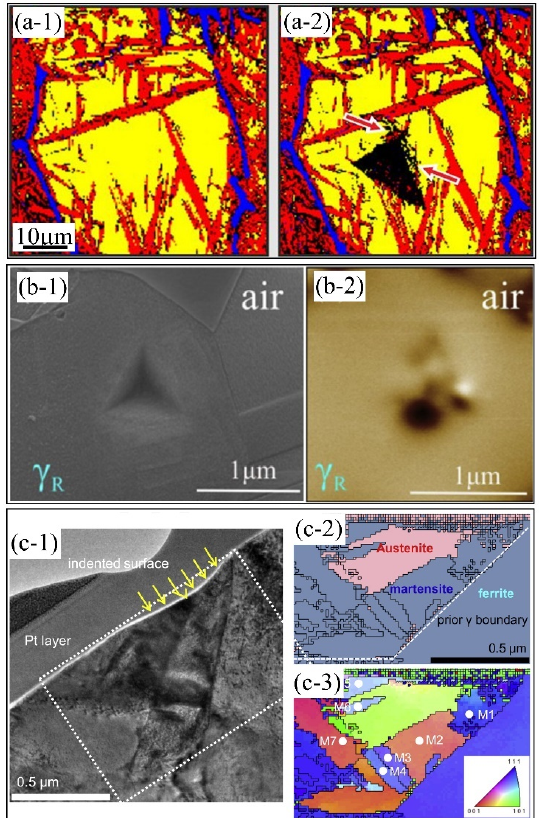
Figure 6. The detection of the martensitic transformation during the nanoindentation test using different techniques, including the ( a ) EBSD measurement [106], Reprinted with permission from ref. [106]. Copyright 2020, Elsevier; ( b ) MFM [105], Reprinted with permission from ref. [105]. Copyright 2019, Elsevier; and ( c ) FIB-TEM/EBSD [94], Reprinted with permission from ref. [94]. Copyright 2015, Elsevier. ( a-1 ) EBSD phase maps before and ( a-2 ) after indentation test. Red color, yellow color and blue color in ( a ) represents the martensite, austenite, and cementite respectively. ( b-1 ) SEM image; ( b-2 ) MFM image; ( c-1 ) TEM image; ( c-2 ) EBSD phase map; ( c-3 ) EBSD IPF map.